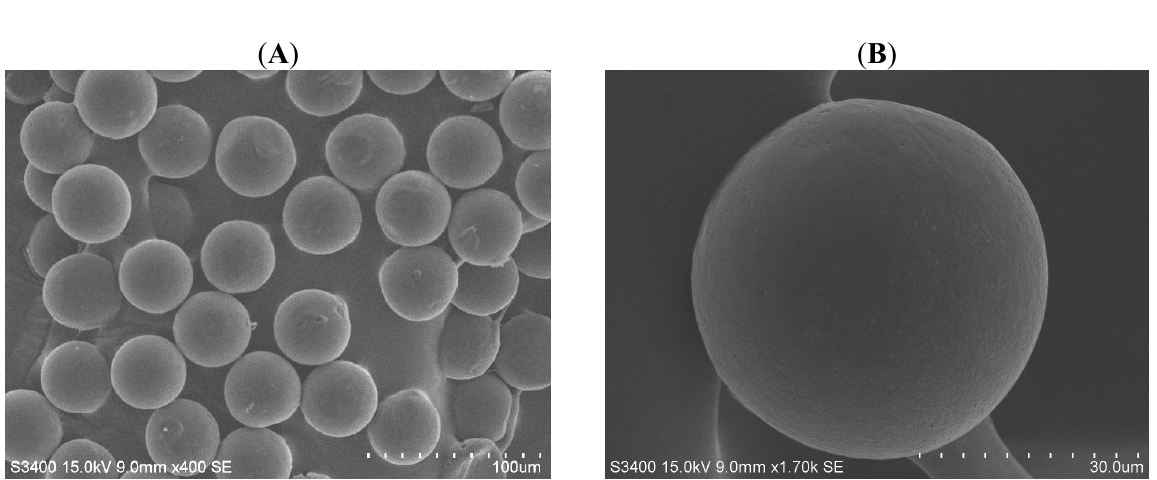
Figure 2. Pictures of PCL microparticles in scanning electron microscope.